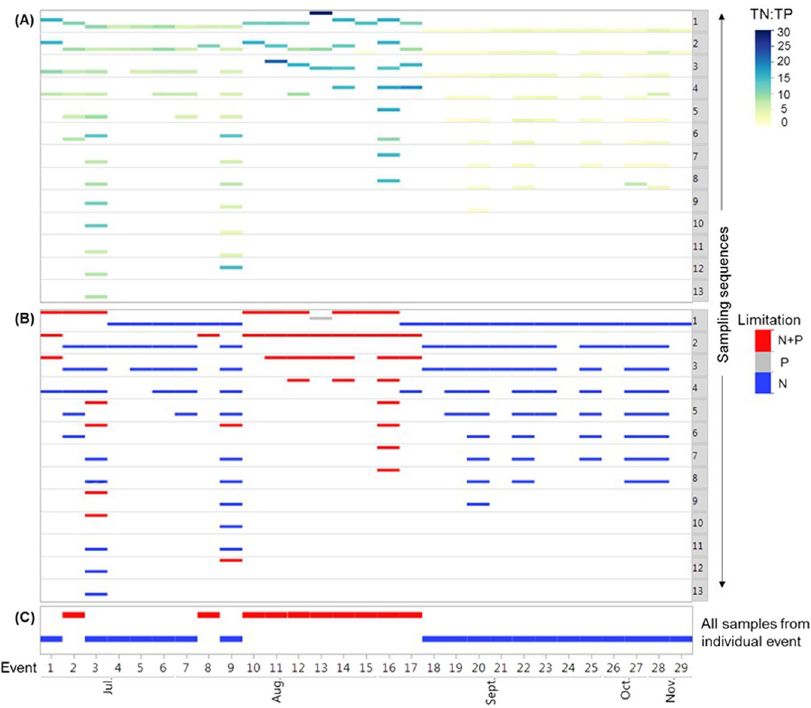
Figure 4. Heatmap showing ( A ) TN:TP, ( B ) N and P limitation in stormwater runoff (n = 153) from 29 individual events during July–November 2014 with sampling sequences 1 to 13, which refer to individual samples collected in 5 minute intervals during each event, and ( C ) mean event N and P limitation. Strict